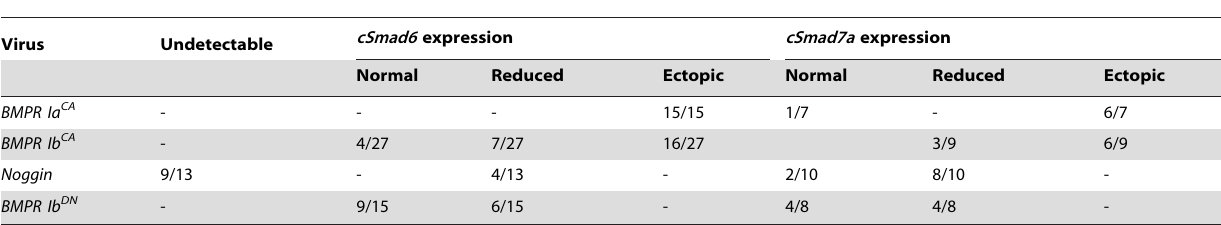
Number of limbs displaying result/total number of limbs examined.